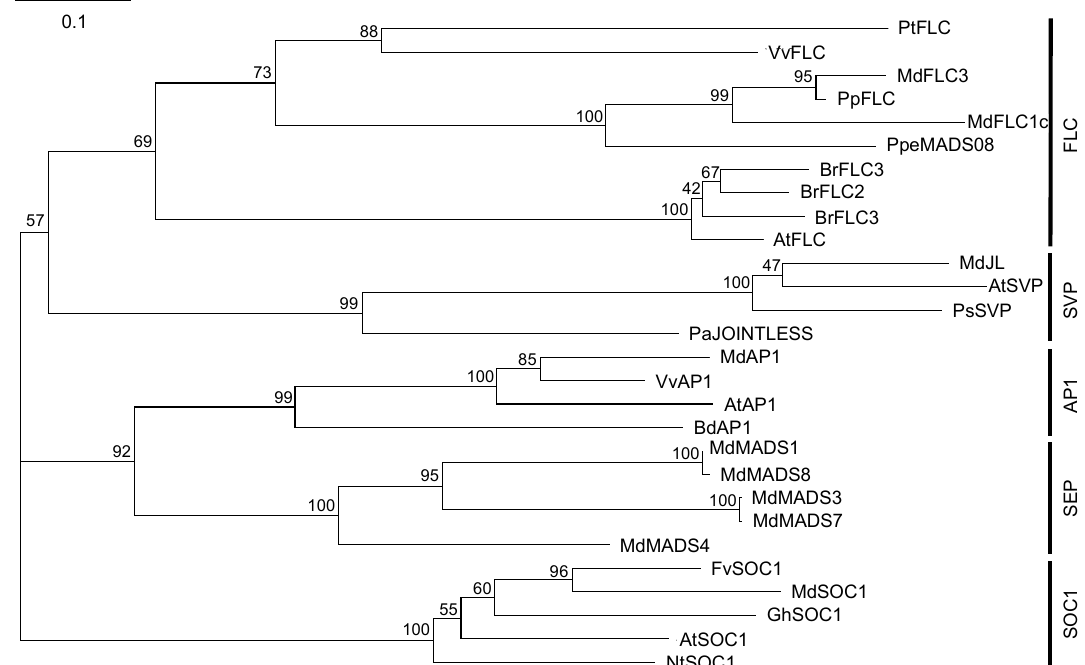
Figure 2. A phylogenetic tree based on the amino acid sequences of FLC, SVP, AP1, SEP, and SOC1 homologs from various species. The tree was constructed by the neighbor-joining method after sequence alignment using the ClustalW program. Branch numbers refer to percentage of replicates that support the branch using the bootstrap method (1000 replicates). The scale bar corresponds to 0.1 amino acid substitutions per residue. The accession numbers of the proteins added to construct the phylogenetic tree are as follows: PtFLC (EU497676), VvFLC (GU133630), PpFLC (KP164015), BrFLC1